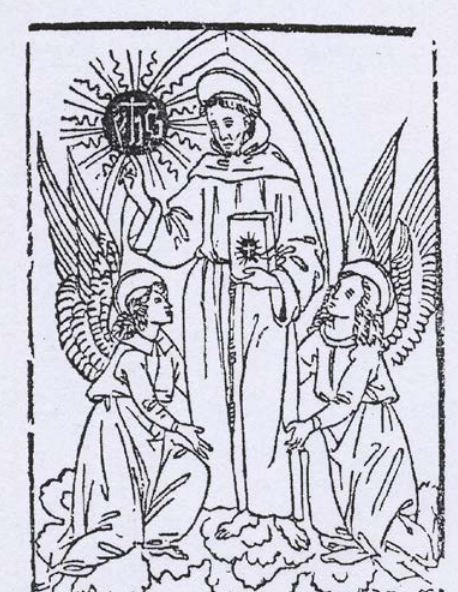
Figure 33 – Vita di San Bernardino , s.n.t. [ma Firenze, Lorenzo Morgiani (e Johann Petri?), post 28 VIII 1496], (from Kristeller 1897, n. 54a, 19, cut 10), Cornell University Library, Public Domain,